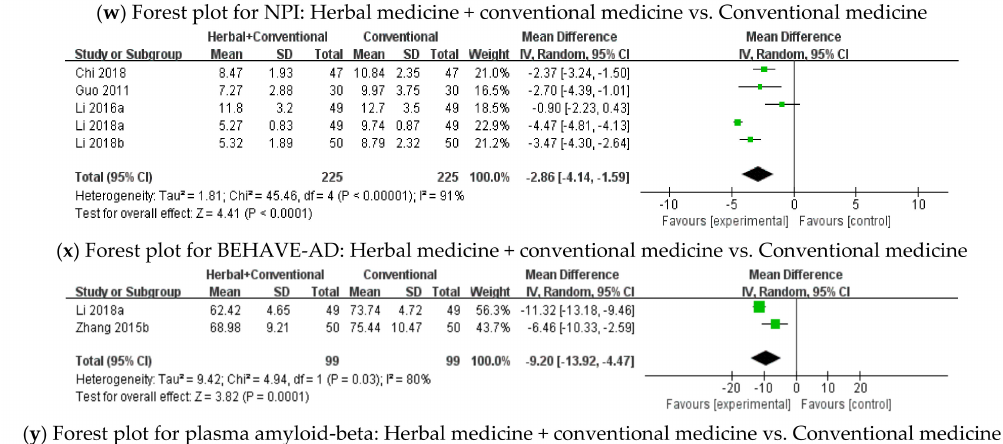
Figure A1. Forest Plots.